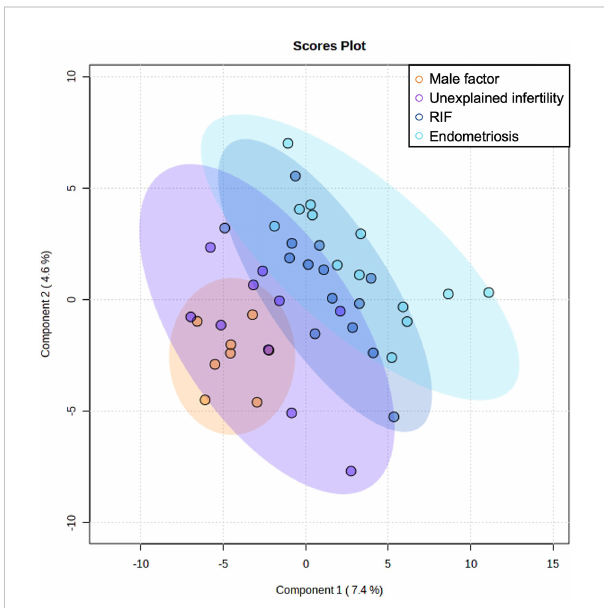
FIGURE 1 Multivariate Partial Least Squares Discriminant Analysis scores plot from women with male factor infertility, unexplained infertility, endometriosis, and recurrent implantation failure (RIF).